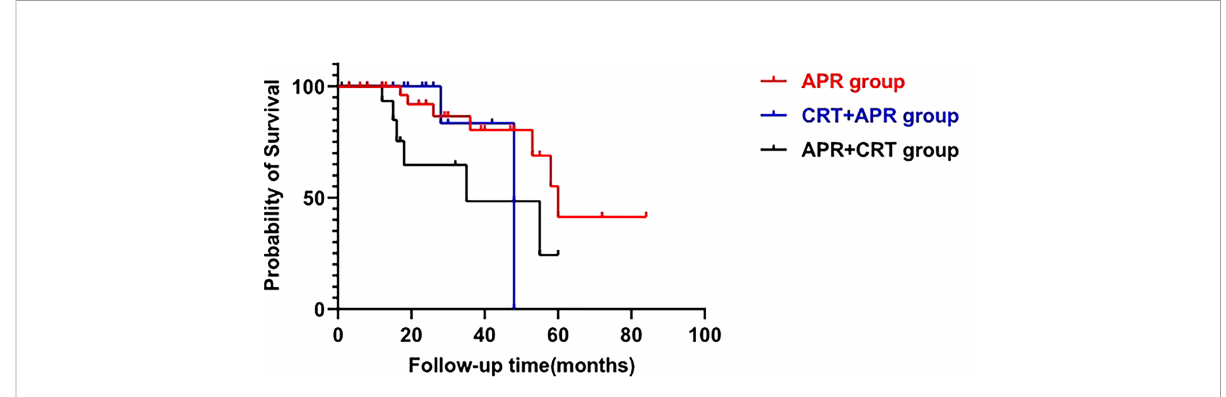
FIGURE 3 Overall survival across three treatment modalities. (log-rank test;